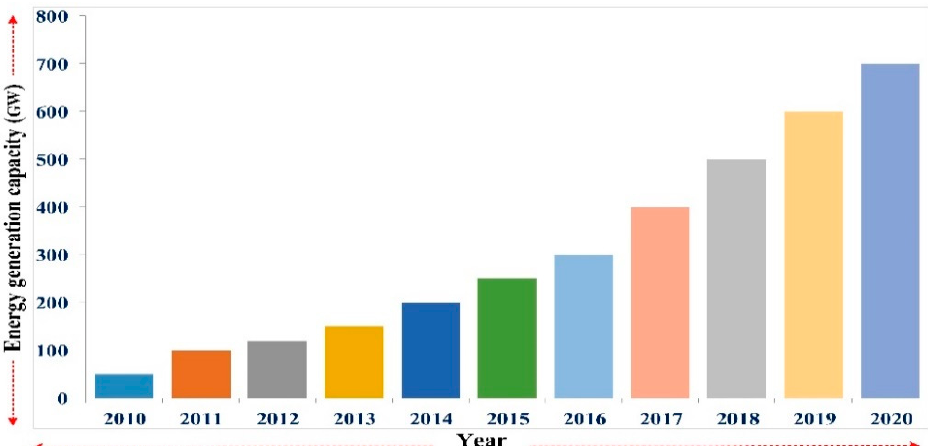
Figure 1. Photovoltaic energy generation capacity over the years [1].